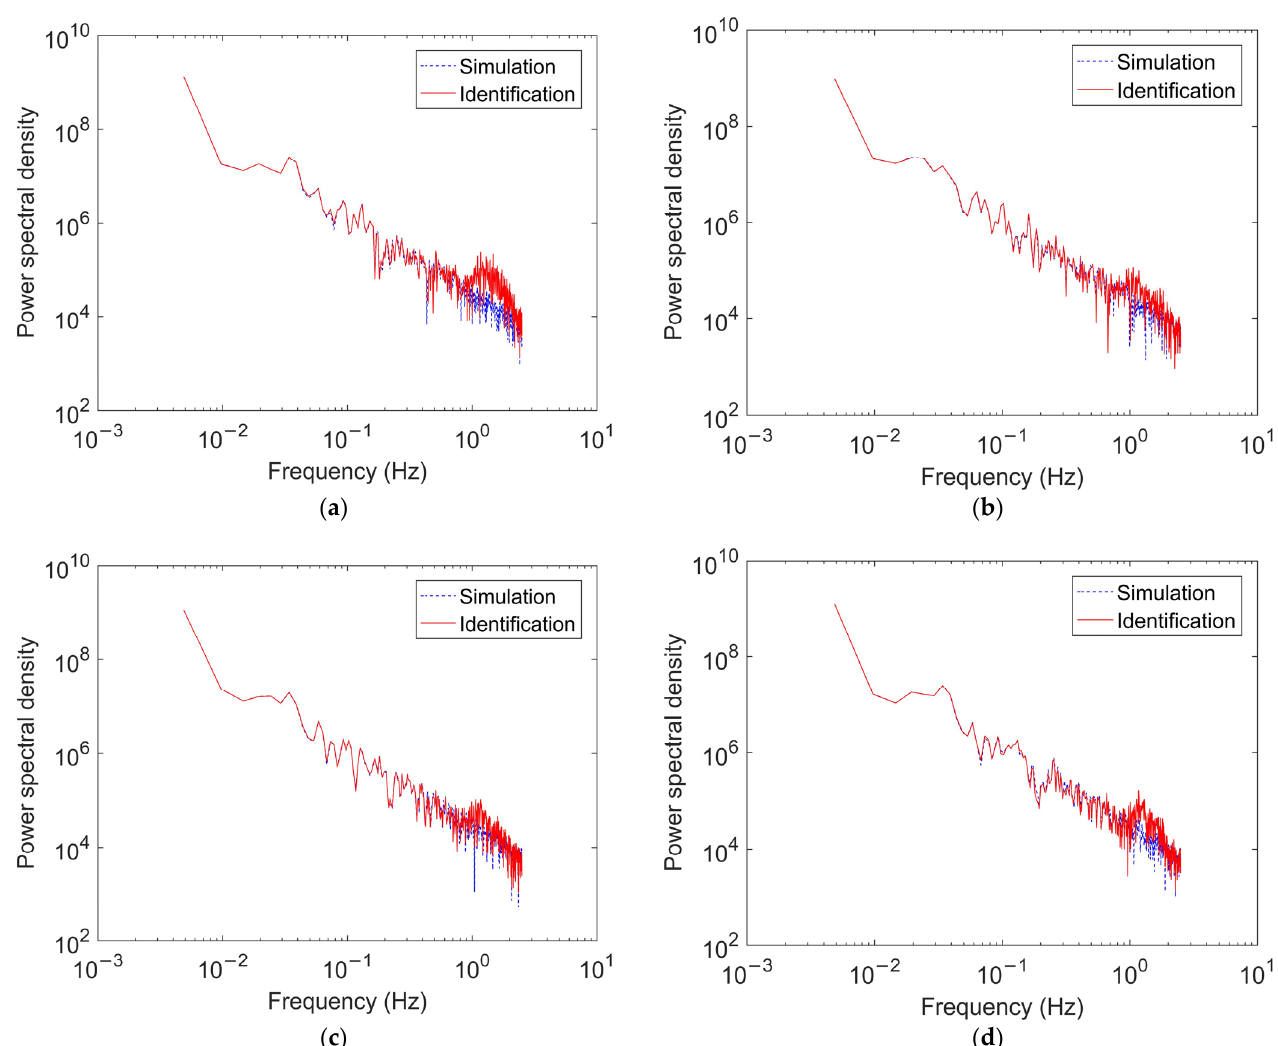
Figure 7. Comparison of wind load frequency domain at the ( a ) 1st floor, ( b ) 6th floor, ( c ) 12th floor and ( d ) 20th